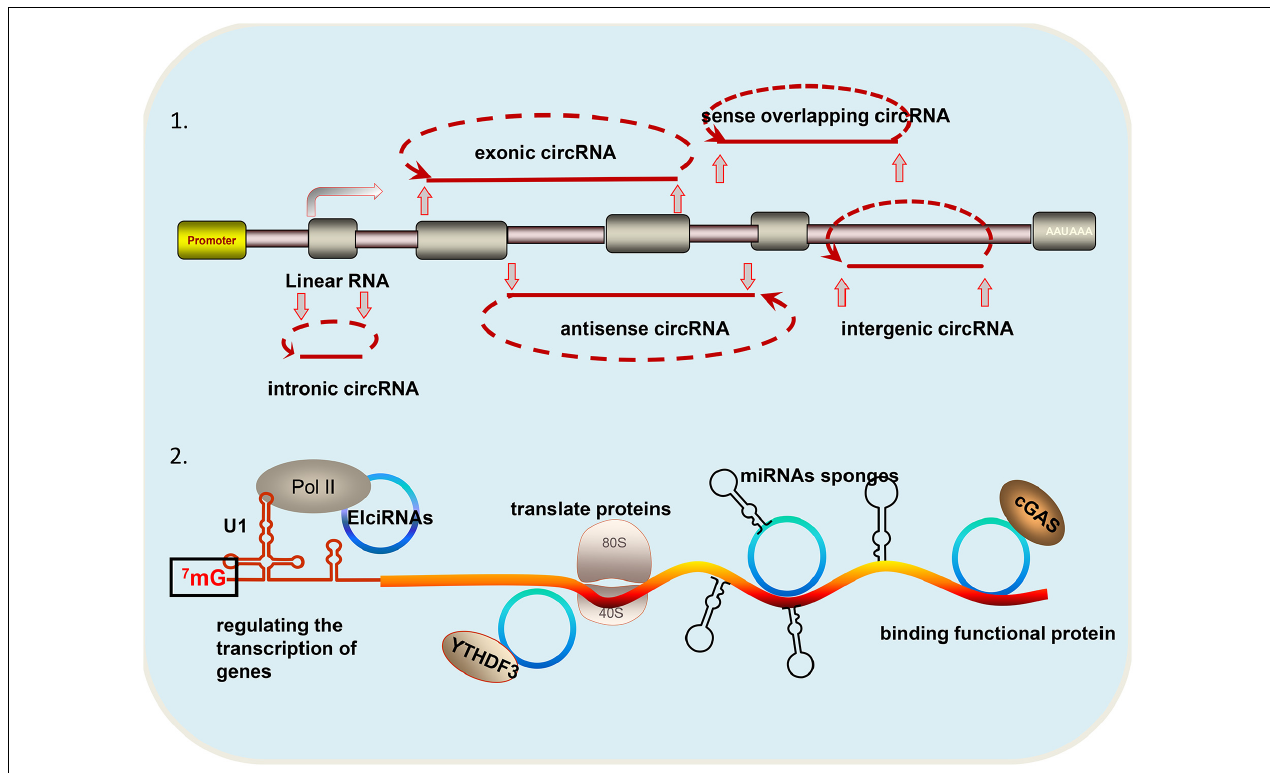
FIGURE 1 | Different types and functions of circRNAs: (1) According to the source of circRNA, it can be divided into the following categories: circular intronic RNAs (ciRNA) derived from gene introns; exonic circRNA (ecircRNAs) derived from gene exons; intergenic circRNAs derived from breakpoints between known genes; antisense circRNA derived from the antisense strand of a known gene; and sense overlapping circRNA: derived from the same gene locus as the linear transcript. (2) CircRNAs have the following four functions: regulating the transcription of genes; translating proteins; acting as miRNA sponges; and binding functional